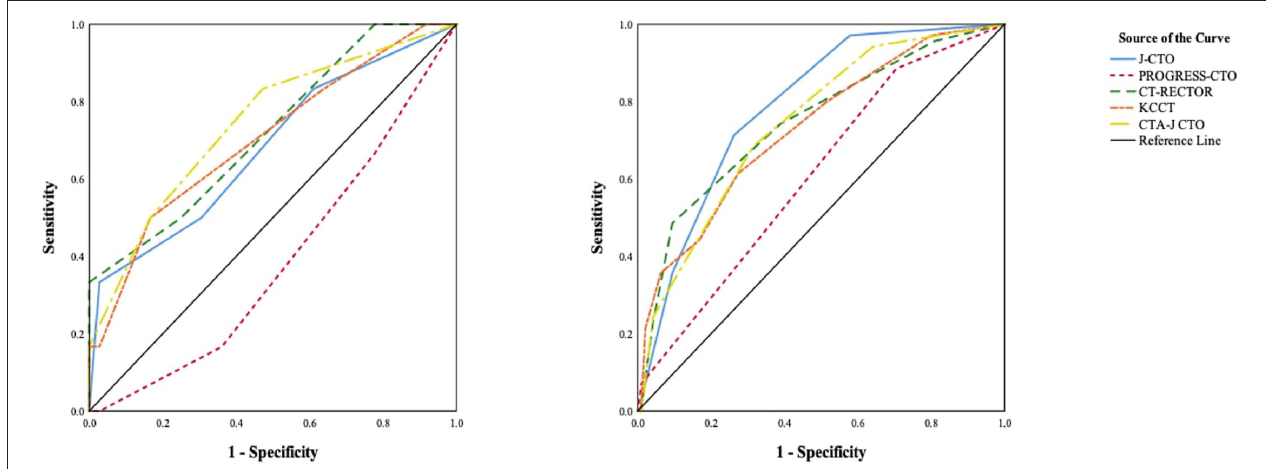
FIGURE 4 | Receiver operating characteristics (ROC) curves of previous scoring systems in patients with soft CTO (left) and hard CTO (right).